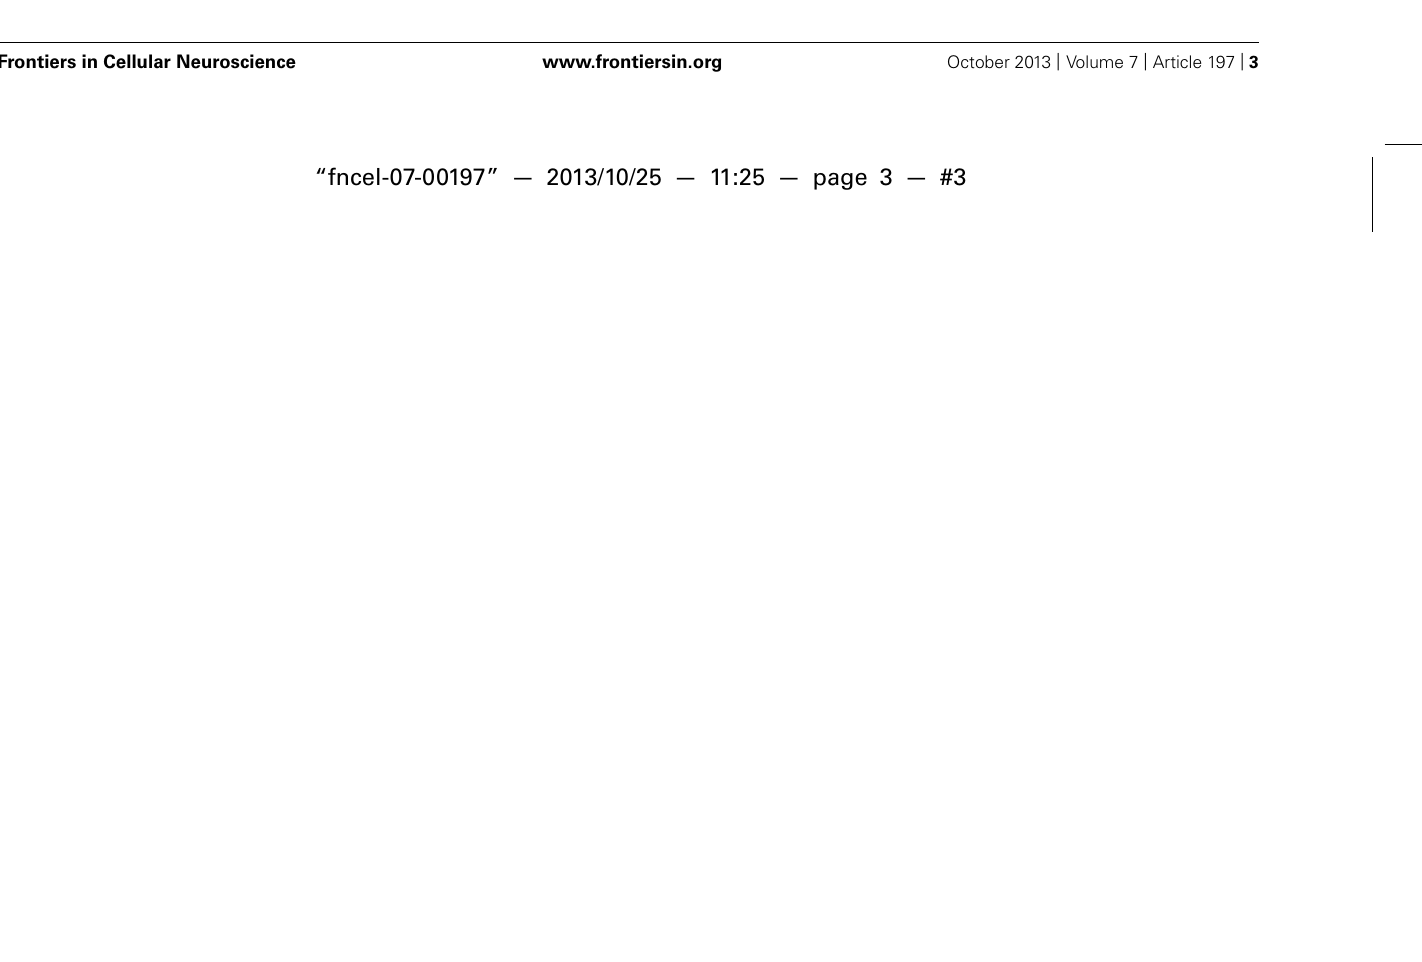
FIGURE 1 |The coordinated action of glial and neuronal purinergic receptors and purines in the CNS. Pre-synaptic terminals exocytotically release both glutamate (GLUT) and ATP as co-transmitters. Extracellular ATP is broken down by ectonucleotidases to ADP and adenosine (ADO), with ATP and ADP acting post-synaptically on P2X and P2Y receptors subtypes, while glutamate acts post-synaptically on α -amino-3-hydroxy- 5-methyl-4-isoxazole propionic acid receptors (AMPARs) and/or N -methyl- D -aspartate receptors (NMDARs). Conversely, the ATP released and its breakdown products, ADP and adenosine (ADO), also act pre-synaptically to modulate neurotransmitter release through the activation of P2X, P2Y, and P1 (A3) receptors. Resting microglia express the P2X4 and P2X7 receptors that are involved in neuropathic pain. ATP promotes